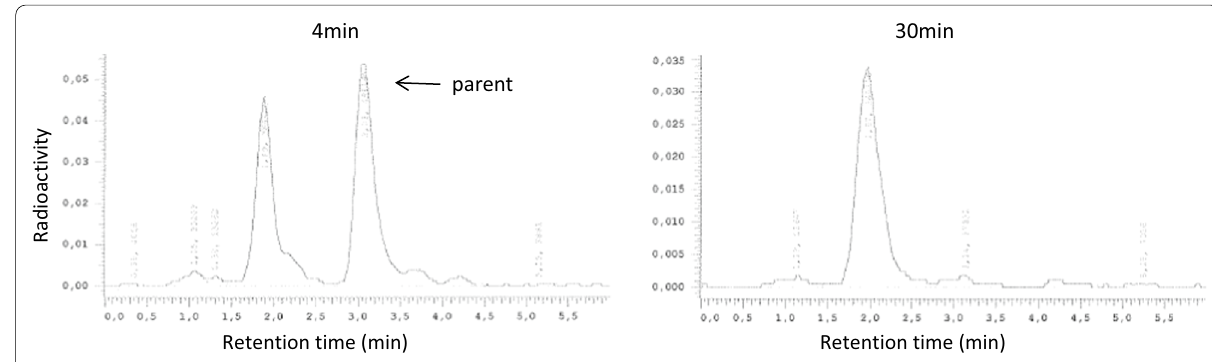
Fig. 3 Radio-HPLC of baseline condition at 4- and 30-min post administration of [ 11